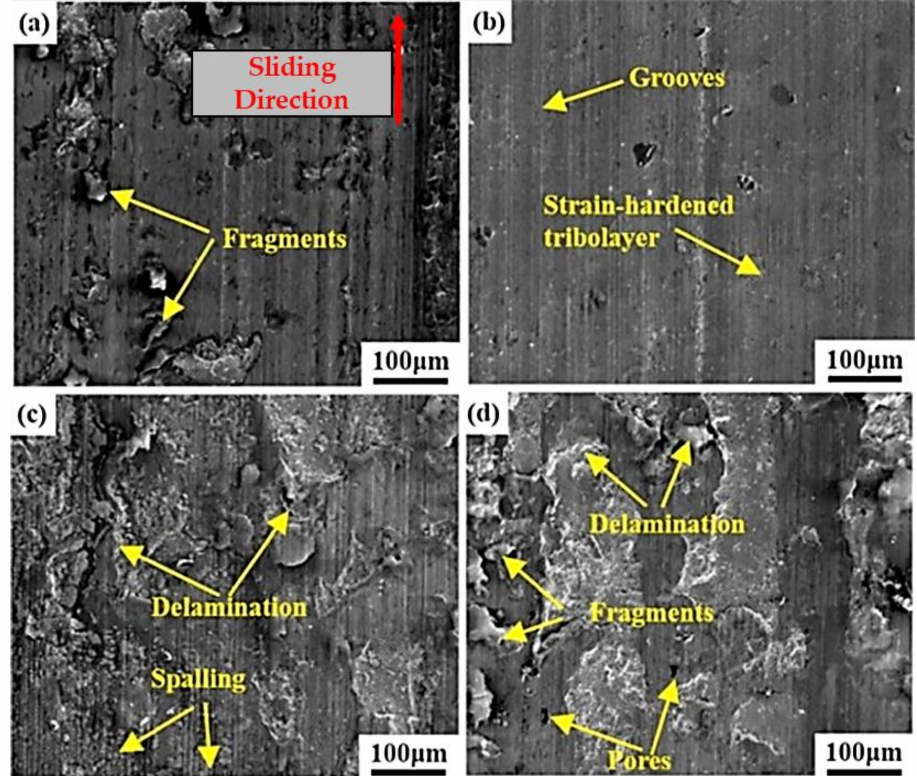
Figure 9. SEM images of the wear track of SLM S136 steel in its ( a ) as-processed condition and with the addition of ( b ) 0.5 wt.%, ( c ) 1.5 wt.%, and ( d ) 2.5 wt.% TiB 2 nanoparticles [101] Copyright 2022